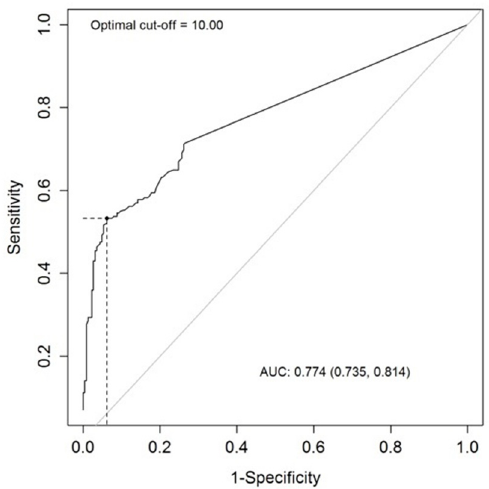
Figure 1. Analysis of the predictive ability—receiver operating (ROC) curve analysis for UBC® Rapid at cut-off value 10.0 µg/L with AUC 0.774 for the whole population.